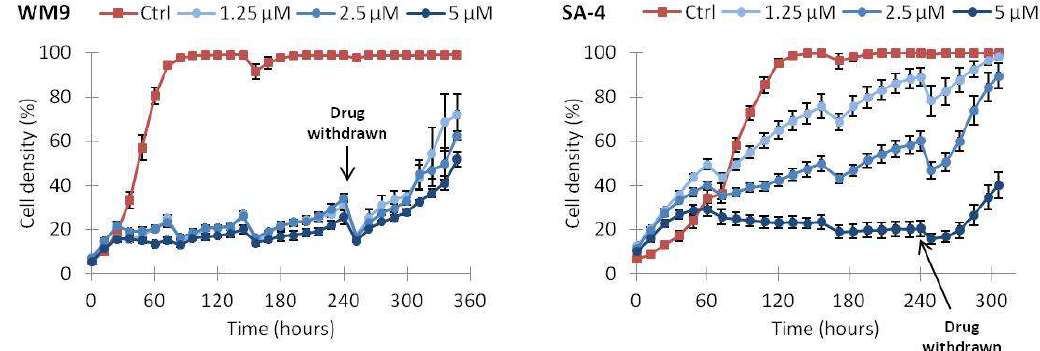
Figure 6. Continuous vemurafenib treatment is required for sustained growth inhibition. Cell lines were treated with the indicated concentrations of vemurafenib or vehicle only (Ctrl) for 240 h and growth medium supplemented with drug was replaced twice a week for this duration. As indicated by the arrows, after 240 h drug-containing medium was replaced with regular growth medium. Irregularities in growth curves are caused by loss of poorly attached cells by media change. One representative experiment is shown ( n = 2). Error bars represent standard error of mean (SEM) of three technical replicates.